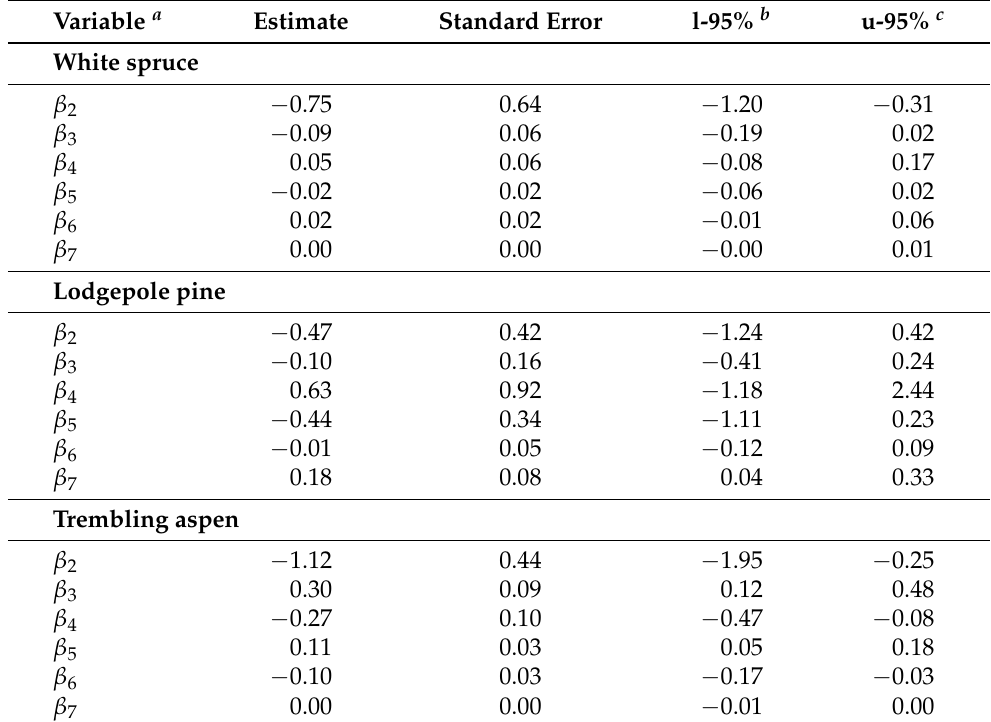
Table 5. Parameter estimates of the final model for each